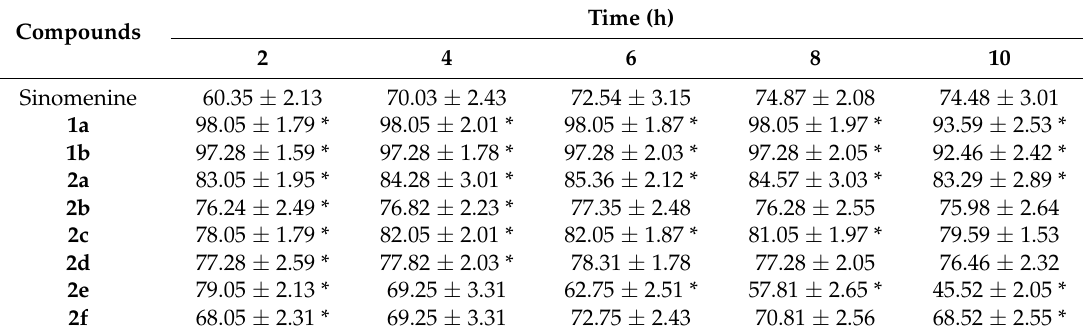
Table 1 . The permeation rate for Sin and Sin derivative patches through mouse skin. Table 1. The permeation rate for Sin and Sin derivative patches through mouse skin. Compounds Compounds